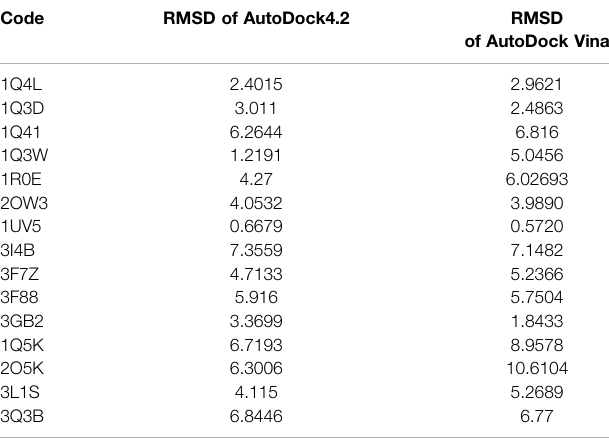
TABLE 1 | Result of redock by AutoDock4.2 and AutoDock Vina